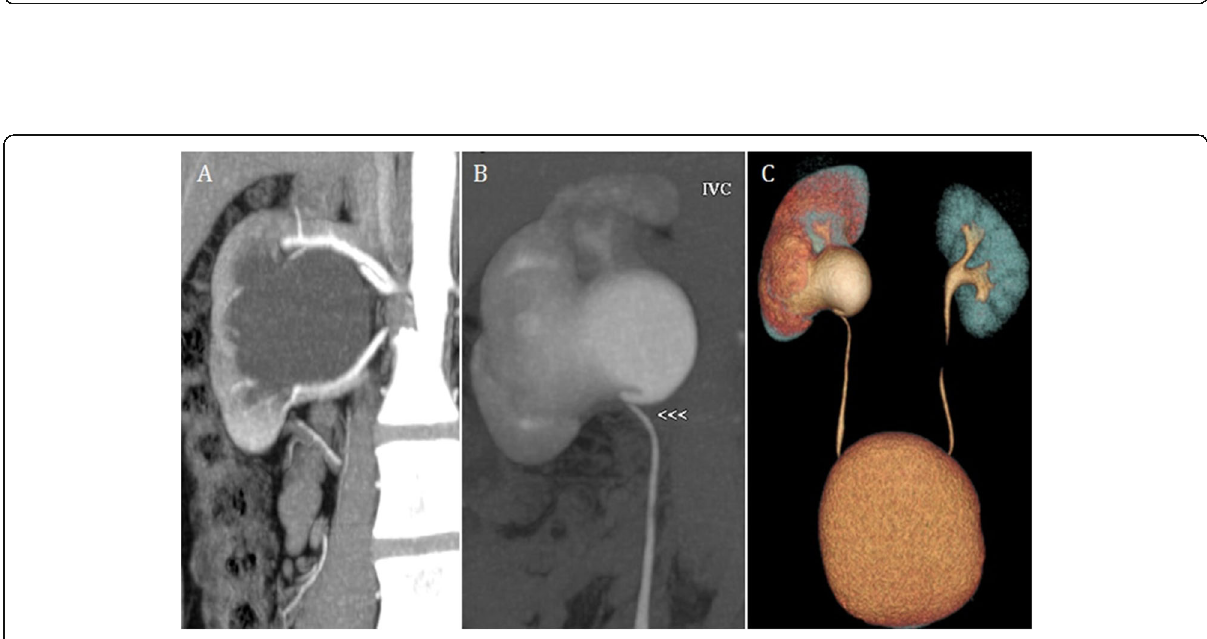
Fig. 8 28-year-old male with hydronephrosis secondary to PUJ obstruction due to anterior crossing of the accessory right renal artery. ( a ) shows hand diagram in coronal view illustrating this condition. Axial and sagittal views ( b and c ) of contrast-enhanced CT study of the abdomen in arterial phase show the dilated pelvicalyceal system due to the compression at the level of pelviureteric junction due to anterior crossing of the accessory right renal artery (arrow). The hand diagram is self-drawn by the author